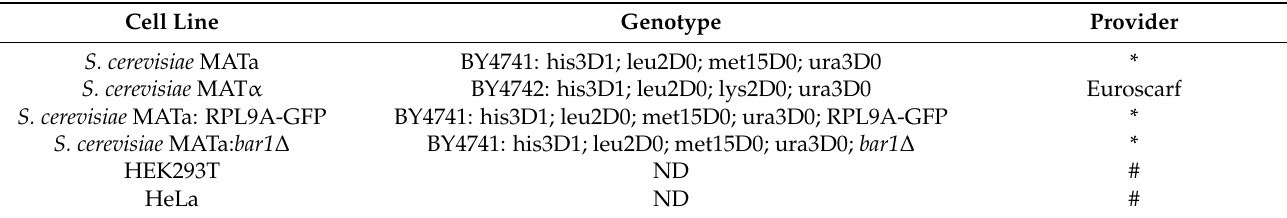
Table 2. Cell lines used in this